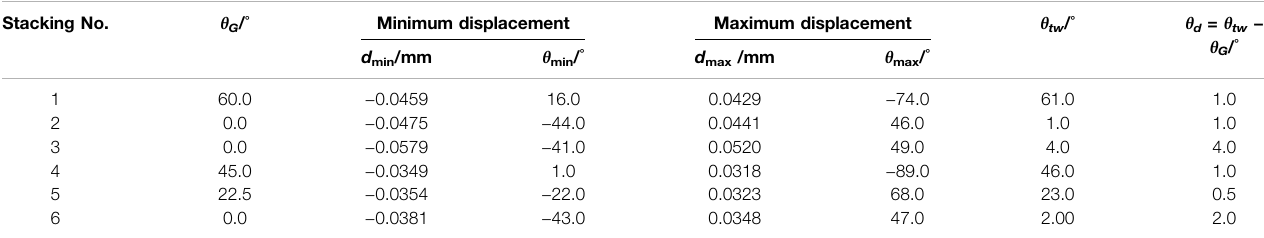
TABLE 3 | Results of the generalized ply angles and angles of minimum and maximum displacements with unit ply angle misalignment in the fi rst layer. Stacking No.